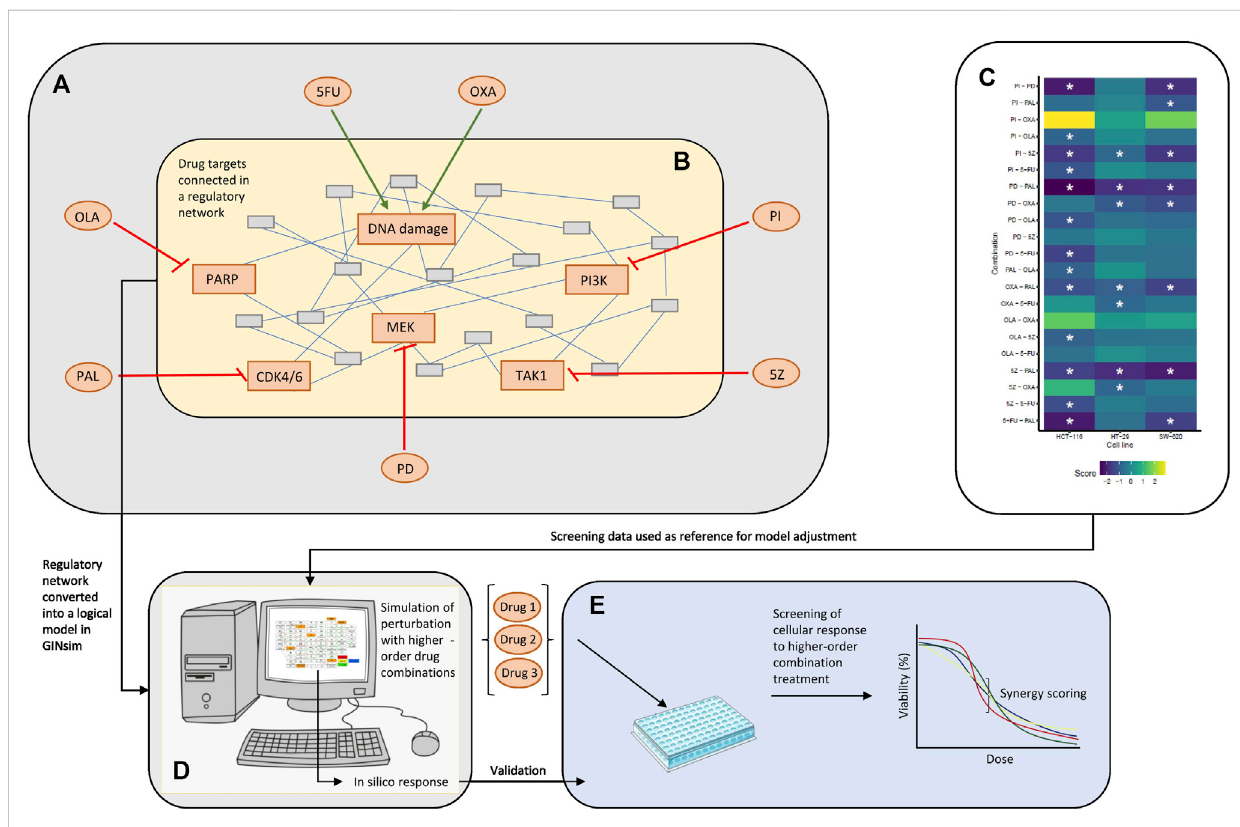
FIGURE 1 Overview of the study. (A) Drugs tested in single and combined (pairwise) in a high-throughput screen by Folkesson et al. (Folkesson et al., 2020). 5FU, OXA, PI, 5Z, PD, PAL, and OLA are abbreviations of 5- fl uorouracil, oxaliplatin, PI-103, 5Z-7-oxozeaenol, PD-0325901, palbociclib and olaparib, respectively. (B) Regulatory network constructed around the targets of drugs tested in the published screen. The network in the fi gure represents an arbitrary network of nodes connected through undirected edges. (C) Combination effects observed in the screen, where asterisks mark combinations classi fi ed as synergistic (HSA score < − 0.7) per cell line. Note that three cell lines (HCT-116, HT-29, and SW-620) were evaluated in the published combination screen, whereas the logical model was mainly adjusted for HCT-116 cells. (D) Logical model simulations of the